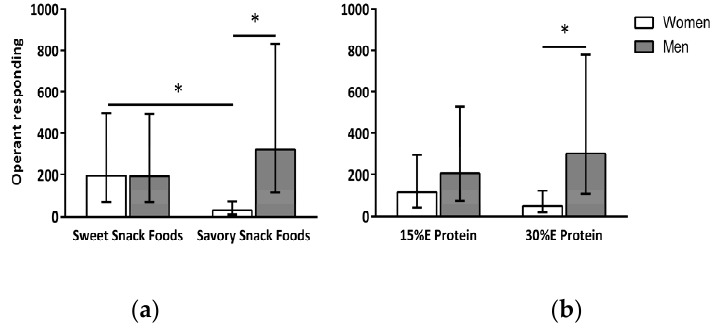
Figure 1. Interaction between gender and snack food type ( a ) and between gender and dietary protein ( b ) on snack food reinforcement. Data are expressed as back-transformed means ( − 1SE, +1SE). * indicates a significant ( p < 0.05) difference between means. As shown in ( a ), reinforcing value as measured by operant responding was greater for sweet than savory snack foods for the women only. Reinforcing value of savory snack foods was greater in men than women, but, there was no gender difference in the reinforcing value of sweet snack foods. As shown in ( b ), when the meal contained 30% E protein women’s reinforcing value of snack foods was lower than that of the men.